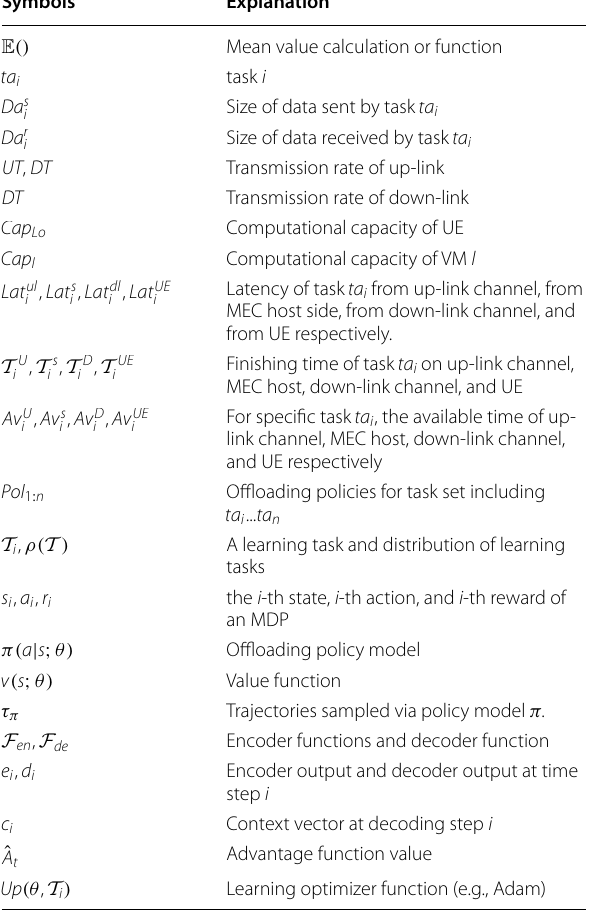
Table 1 Notation